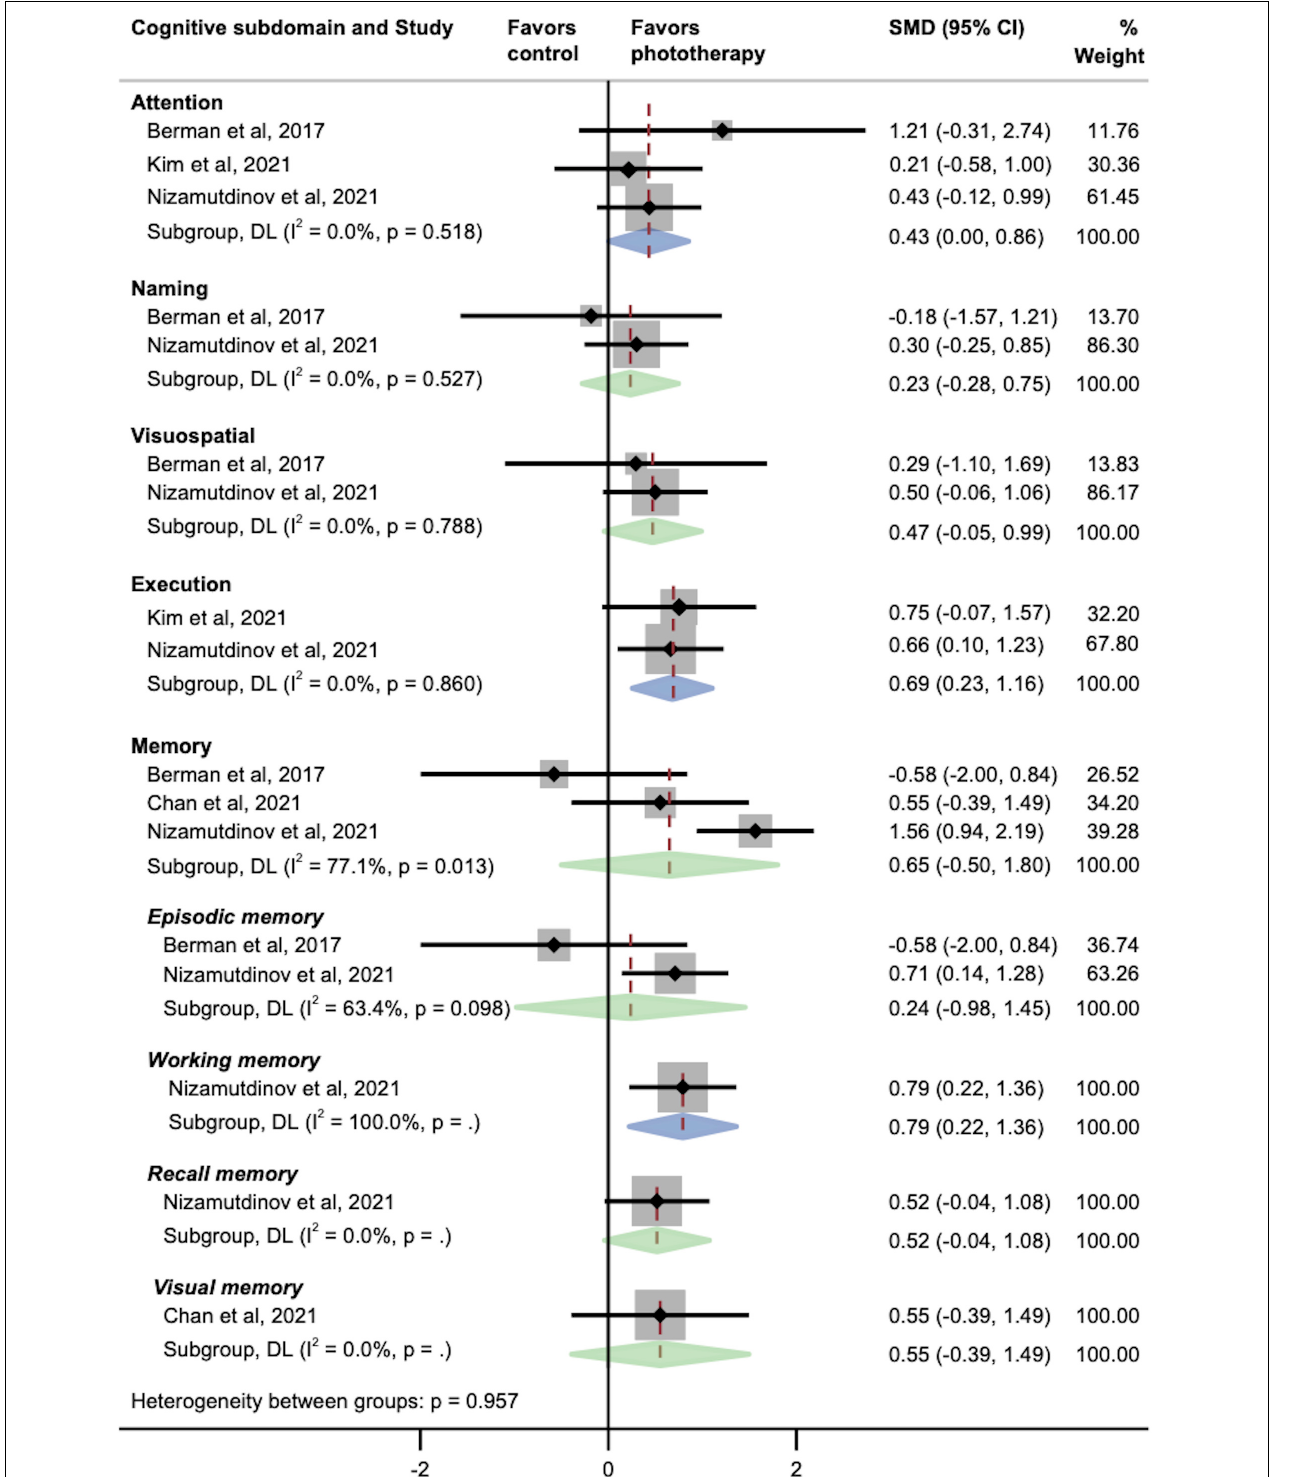
FIGURE 3 | Pooled effects of different cognitive subdomains after phototherapy as compared with control interventions. SMD, standardized mean difference. Weights and between-subgroup heterogeneity test are from random-effects model.